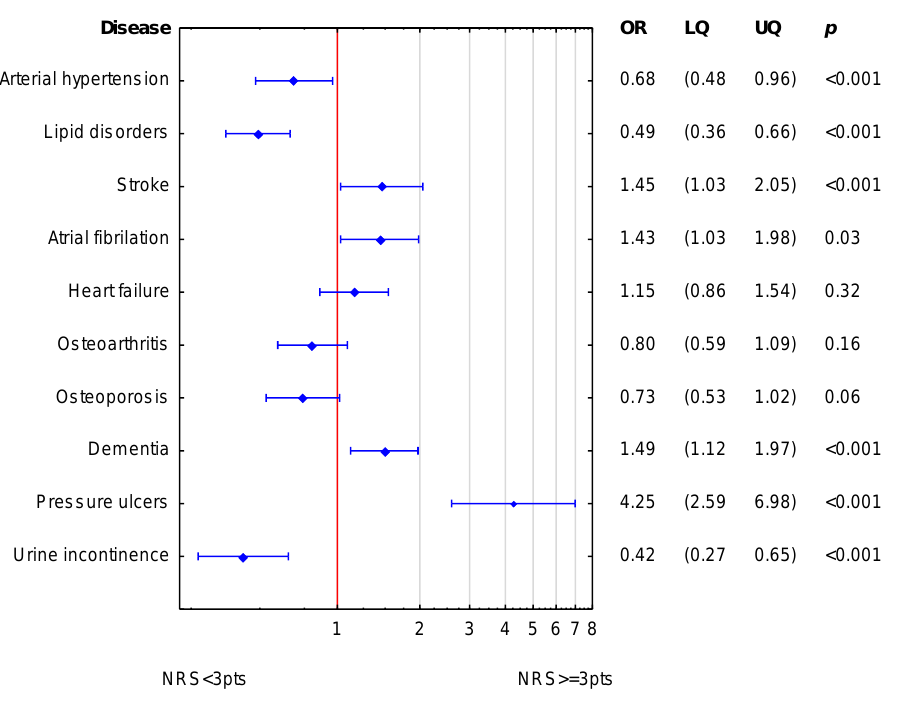
Figure 2. Simultaneous association of accompanying diseases to NRS-2002 in women. (OR—odds ratio; LQ—lower quartile; UQ—upper quartile; p — p value). Reference value (OR = 1; red line) corresponds to the absence of particular disease. Blue symbols correspond to odds ratios and 25–75% confidence intervals for the presence of particular disease Figure 3 shows the simultaneous statistical impact of concomitant diseases on NRS- 2002 in men. Dementia and pressure ulcers were related to higher values of NRS-2002 (increased odds ratio for nutritional risk). Lipid disorders, osteoarthritis and urine incon- tinence were related to lower values of NRS-2002.